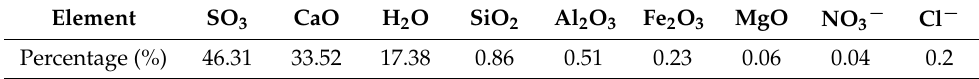
Table 1. Chemical composition of the phosphogypsum obtained from “Elfe SA Industry”. Element SO 3 CaO H 2 O SiO 2 Al 2 O 3 Fe 2 O 3 MgO NO 3 − Cl − Percentage (%) 46.31